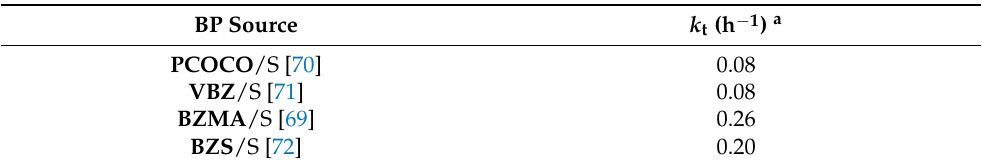
Table 3. First-order rate constants k t for thermal decomposition of various types of pendant BP structures in styrene copolymer films at 91 ◦